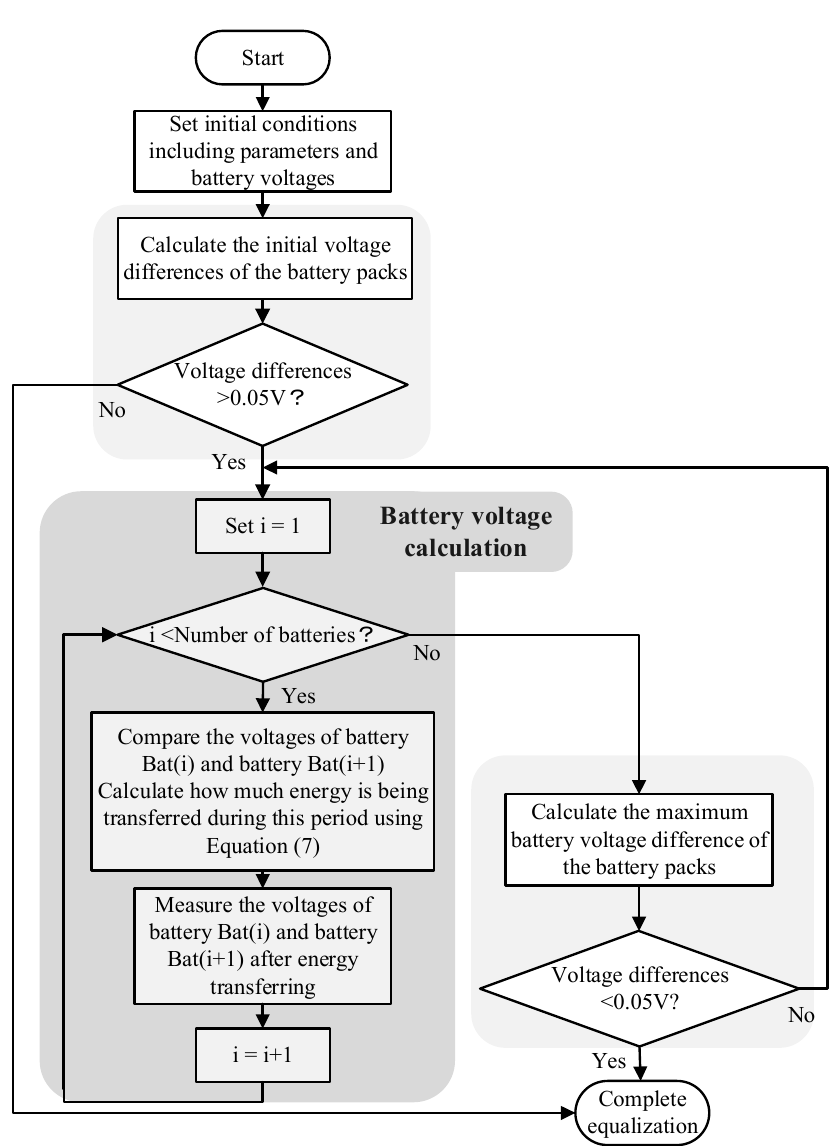
Figure 10. Flowchart of the conventional SC-based BE.